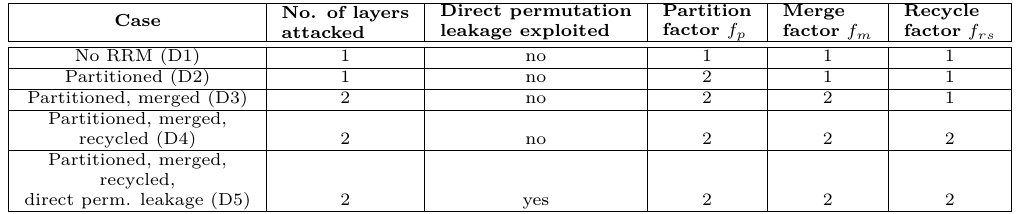
Table 5: Reduced Randomness shuffling schemes analyzed in the context of single-layer and two-layer horizontal attacks, with/without direct permutation